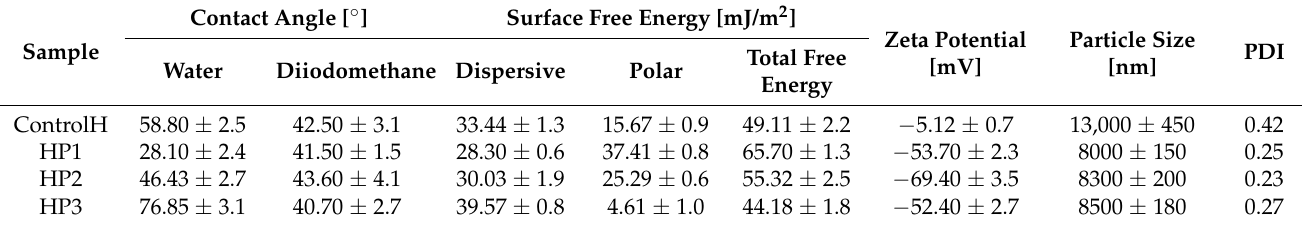
Table 4. Wetting angles, surface free energy (SFE), zeta potential, particle size and polydispersity index